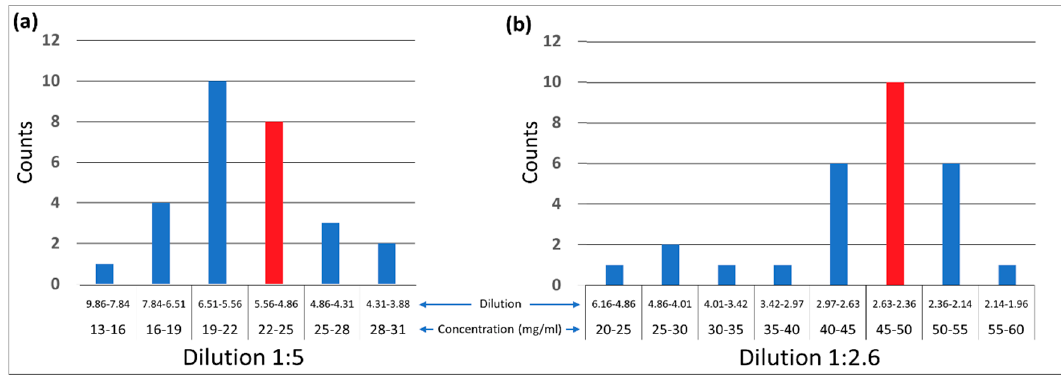
Figure 8. Results of mixing experiments with blood plasma and PBS buffer for two different mixing ratios. Histogram ( a ) shows the concentration distribution for a dilution of 1:5, while histogram ( b ) displays the distribution for a mixing ratio of 1:2.6. The red bars indicate the populations with the target dilution.